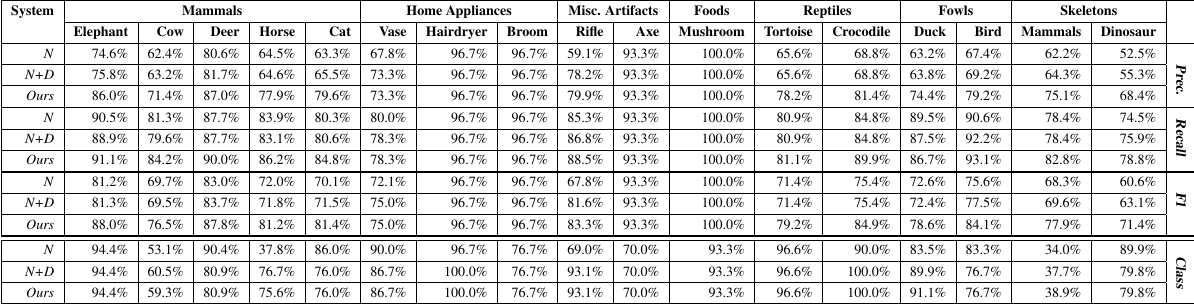
Table 2: Excerpts for segmentation and annotation (top) and classification (bottom).